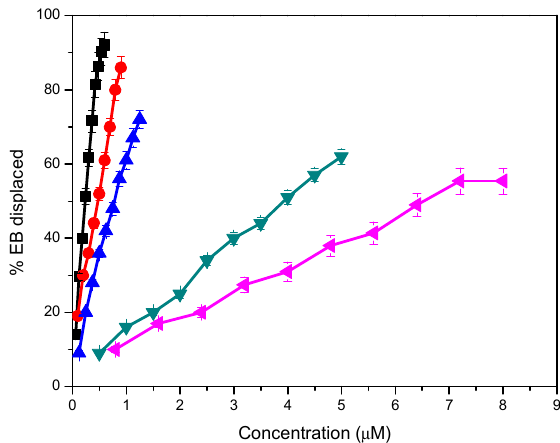
Figure 10. Release of ethidium bromide (EB) (%) from the EB / DNA complex against concentration of cationic surfactants and their catanionic vesicles ( μ M): C 3 (CA) 2 ( ■ ) 8.2 C3L ( ● ), 5.5 C3L ( ▲ ) LAM ( ◄ ), 8.2 LM ( ► ).